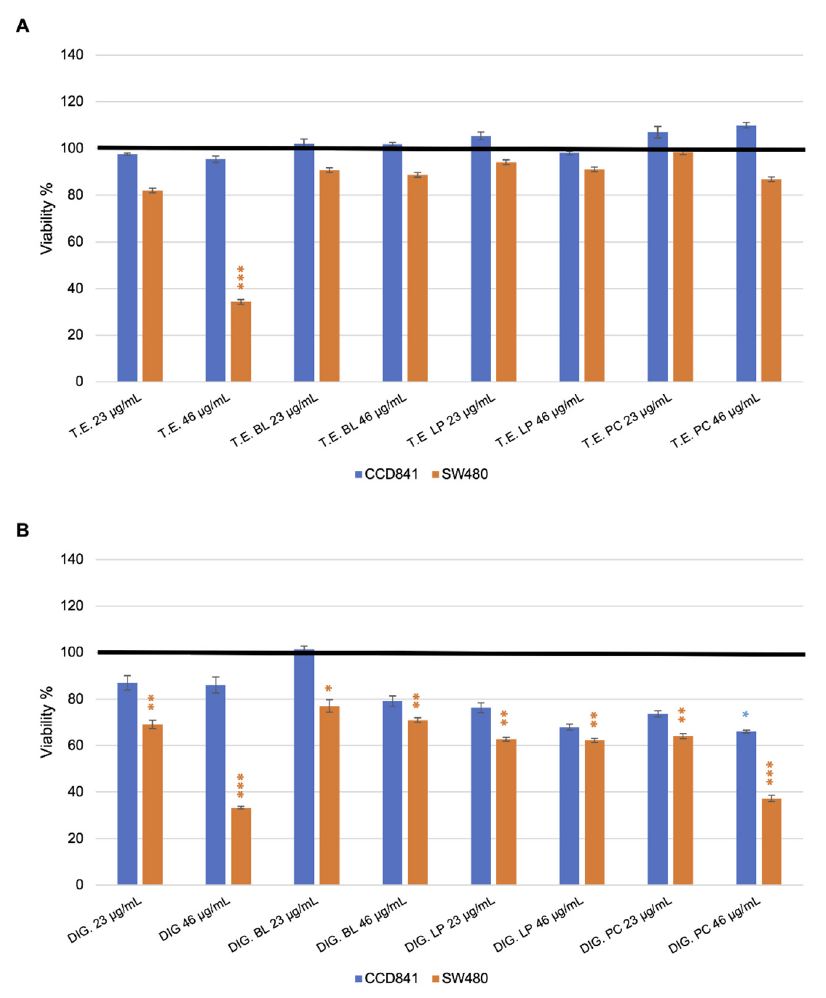
Figure 8. Effects on CCD841 and SW480 in the presence of polyphenol-rich cinnamon bark extract (T.E.), the secondary metabolites produced after the extract fermentation by B. animalis subsp. lactis (T.E. BL), L . plantarum (T.E. LP), and the probiotic consortium (T.E. PC) ( A ). Effects on the vitality of CCD841 and SW480 cell lines in the presence of in vitro digested polyphenol-rich cinnamon bark extract (DIG.), the secondary metabolites produced after the in vitro digested extract fermentation by B . animalis subsp. lactis (DIG. BL), L . plantarum (DIG. LP), and the probiotic consortium (DIG. PC) ( B ). 23 and 46 µgGAEeq/mL of polyphenols were tested. The bold black lines represent the viability of the control condition (100%). Results are depicted as % of mean vitality ± SE. Statistical differences were calculated using Dunnett’s multiple comparisons test: * p -value < 0.1, ** < 0.05, *** < 0.01.